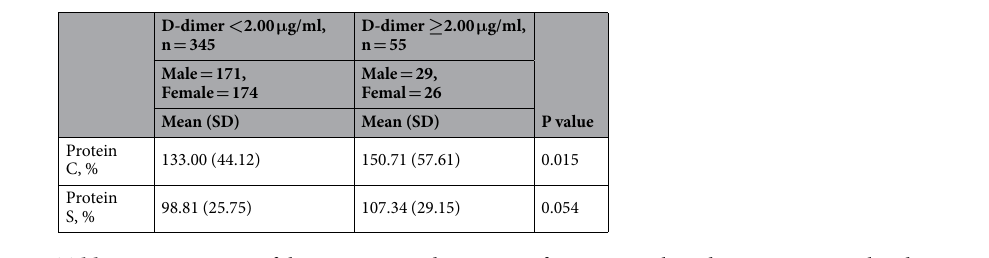
Table 4. Comparison of the Protein C and Protein S of Patients With D-dimer < 2.00 μ g/ml and ≥ 2.00 μ